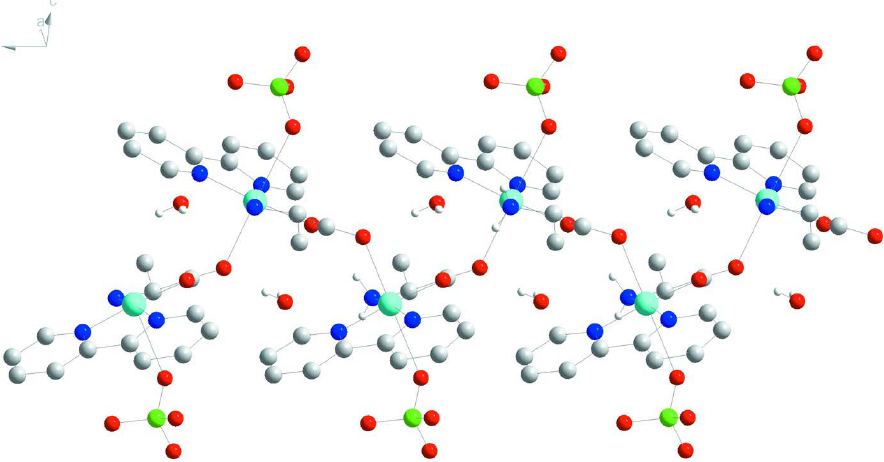
Figure 2 Single strand supramolecular assembly mediated by further coordination of the carboxylato group of the aminoacid. Colour code: cyan = Cu, green = Cl, red = O, blue = N, grey = C. Hydrogen atoms have been omitted for